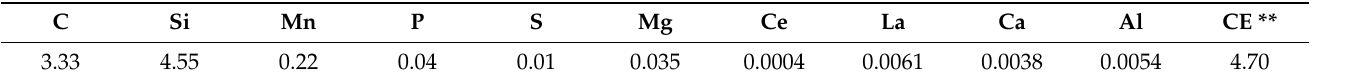
Table 1. Chemical composition of tested cast iron *